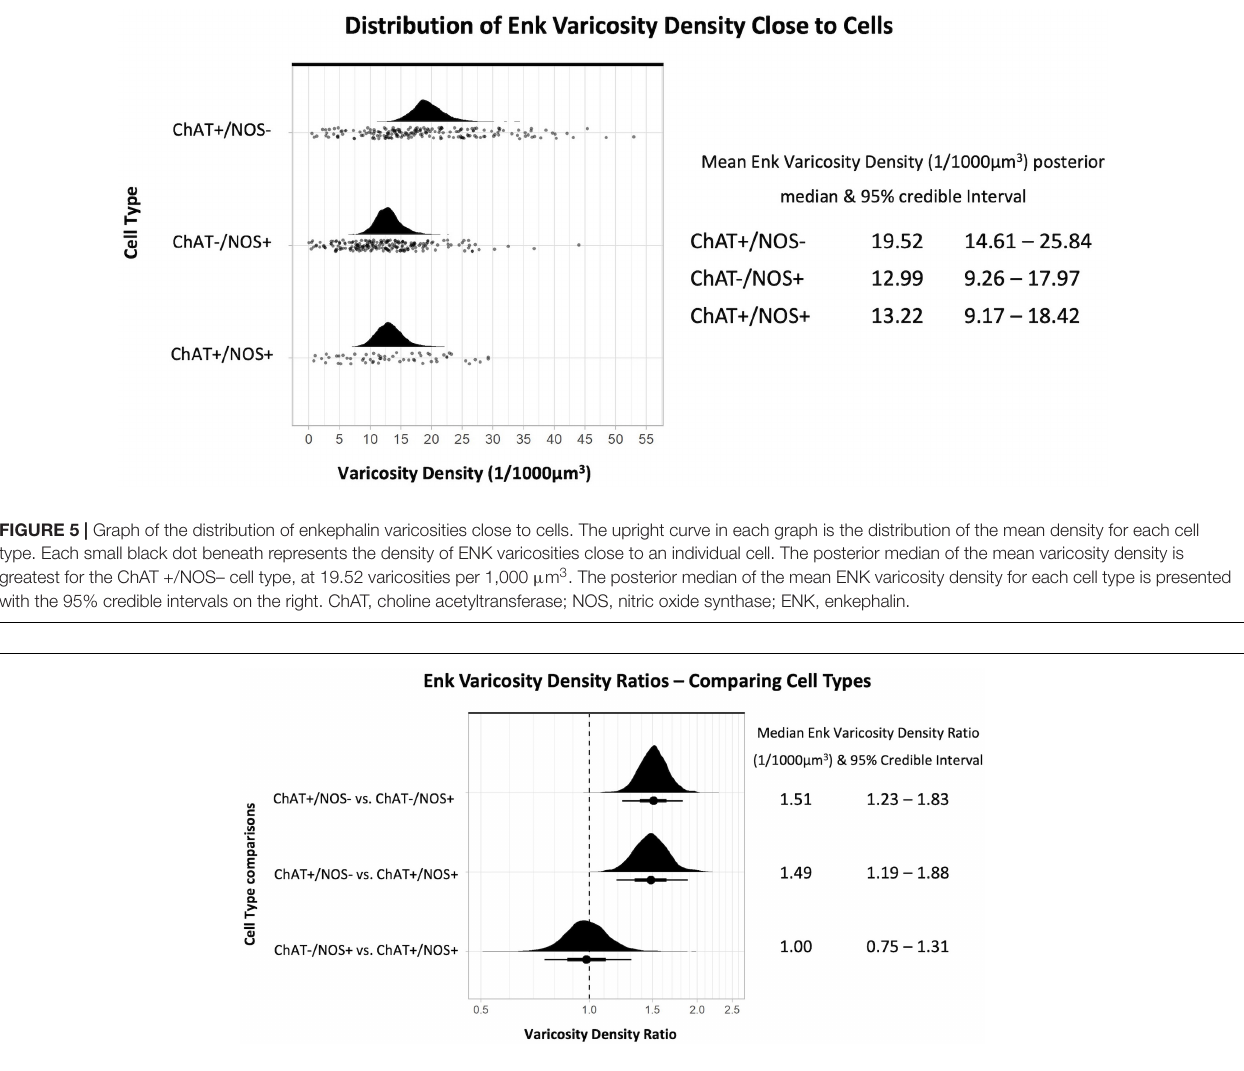
FIGURE 6 | Graph of enkephalin (ENK) varicosity density ratios comparing cell types. Density ratio is on a logarithmic scale. The filled black curves indicate the ratio between the distributions of the mean of density (mean varicosity density of cell type divided by another). The bars beneath indicate the median (dot), the 66th percentiles and the 95th percentiles of the mean. A ratio of 1.0 indicates that the densities for the two types of cells compared are identical. In this graph, ChAT +/NOS– cells compared to the ChAT–/NOS + cells and also compared to the ChAT +/NOS + cells have a median density ratio and 95% percentile bar to the right of 1.0. This shows there is a significantly greater density of ENK varicosities close to ChAT +/NOS– cells compared to both ChAT–/NOS + and ChAT +/NOS + cells. The median ENK varicosity density ratios are presented with the 95% credible intervals on the right. ChAT, choline acetyltransferase; NOS, nitric oxide synthase; ENK,